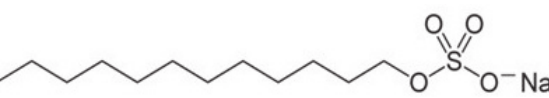
Figure 4. The molecular structure of sodium dodecyl sulfate (SDS) as an anionic chemical synthetic surfactant.